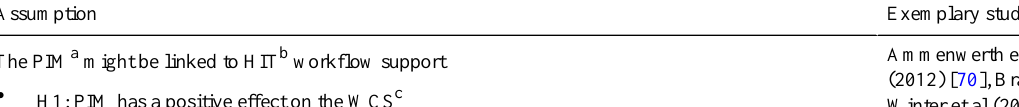
Table 2. Theoretical assumptions and corresponding hypotheses guiding the structural model specification.